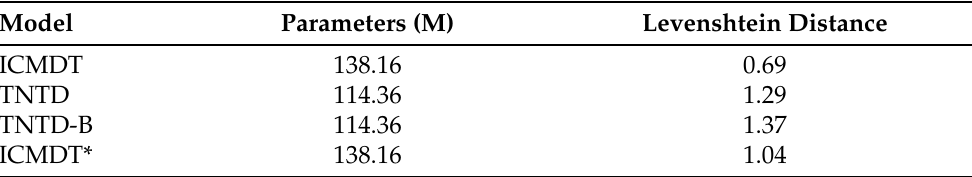
Table 3. A discussion of position encoding as well as feature fusion.